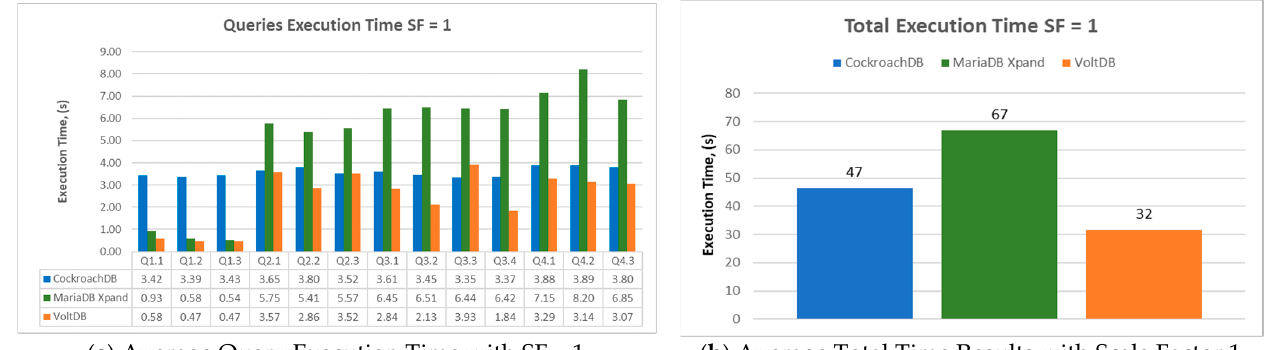
Figure 8. Results of query execution time with SF = 1.